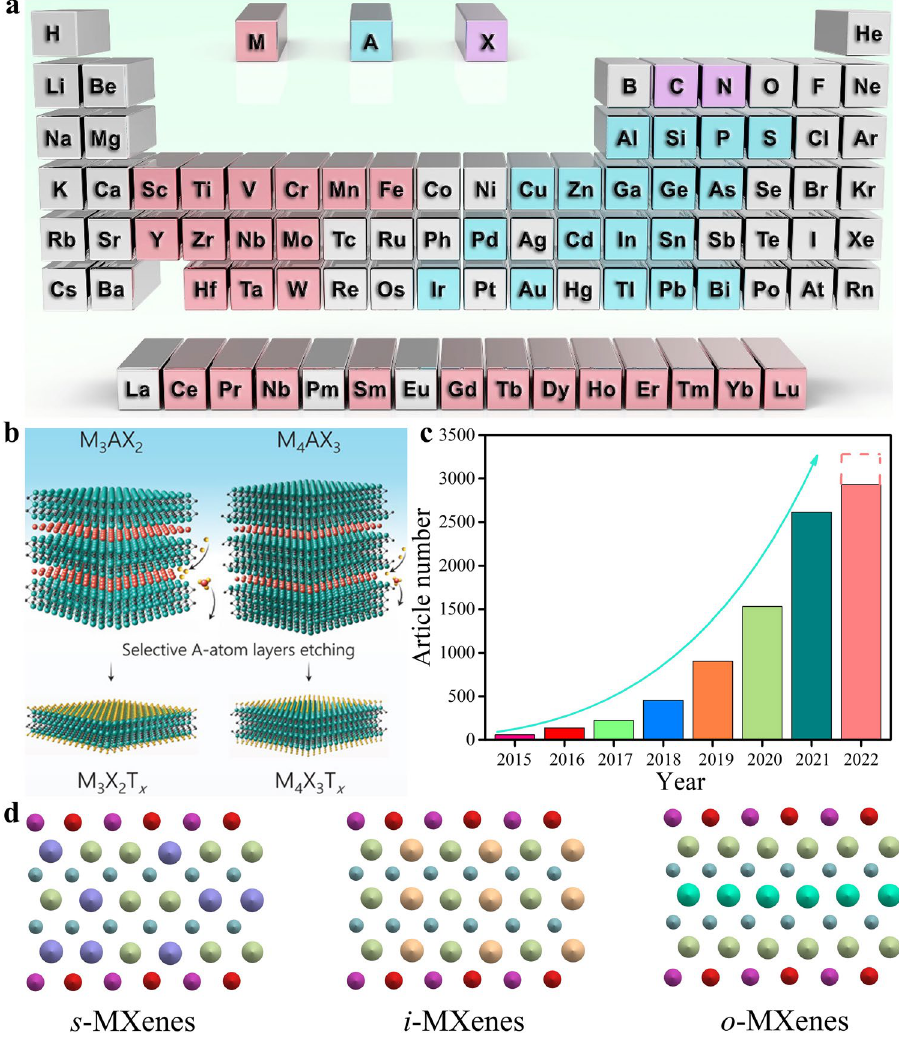
Fig. 1 a Element composition of MAX phase. Reproduced with permission from [16] Copyright 2022, Elsevier. b Schematic illustration of the preparation of various MXenes from corresponding MAX phases. Reproduced with permission from [26] Copyright 2021, Wiley–VCH. c